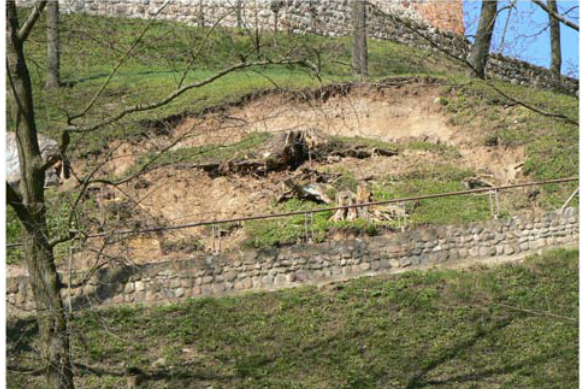
Fig. 2. Dvarčionys slope slip